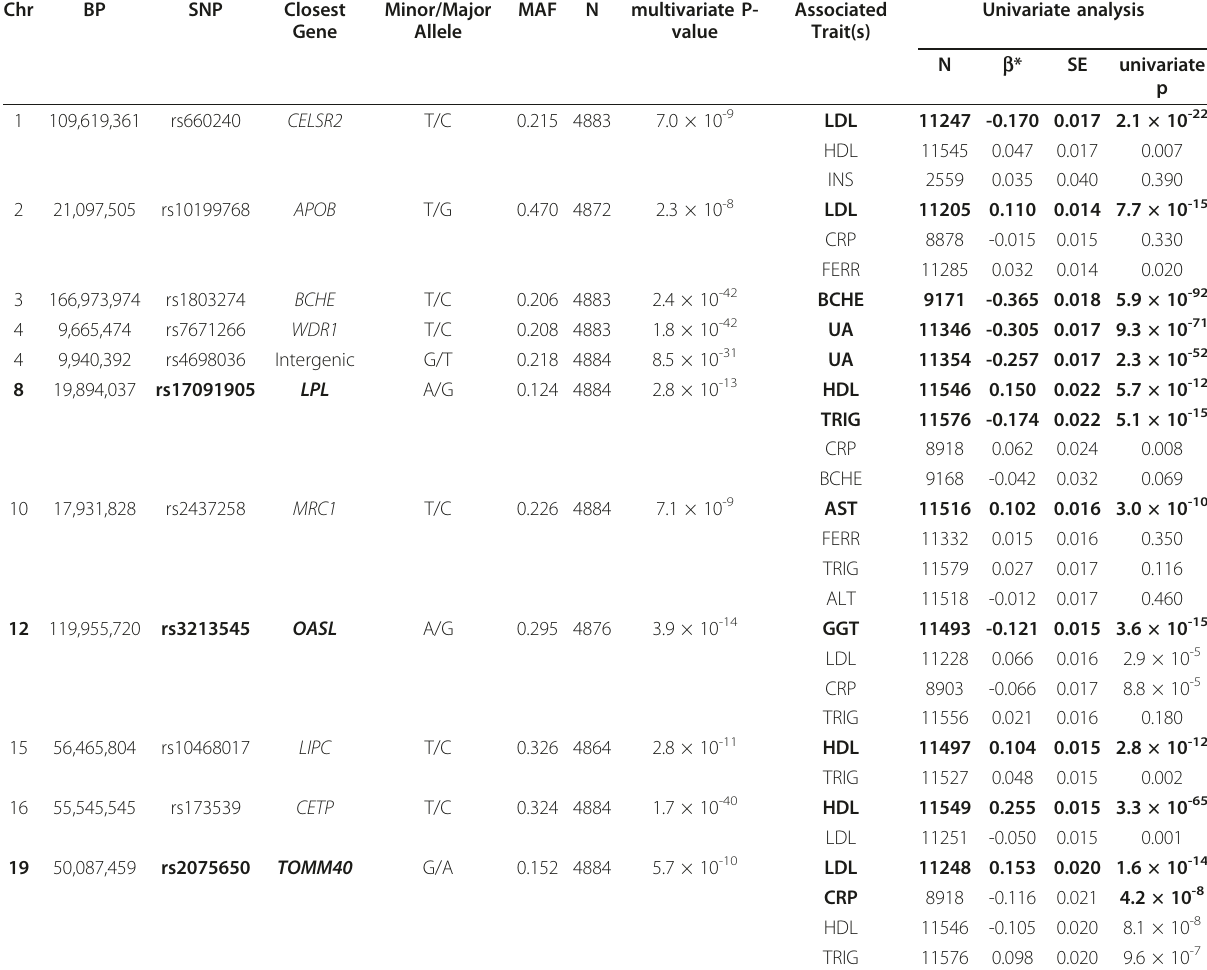
Table 1 Summary of SNP associations (based on multivariate p-value of < 5 × 10 -8 ) Chr BP SNP Closest